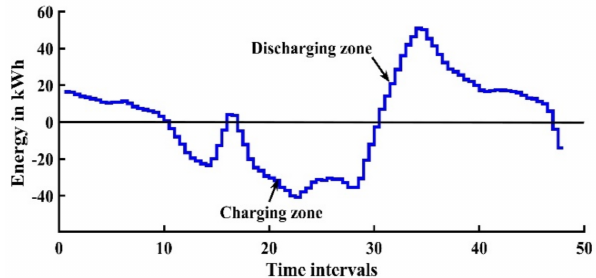
Figure 4. Estimation of zone transition probabilities of an EV.